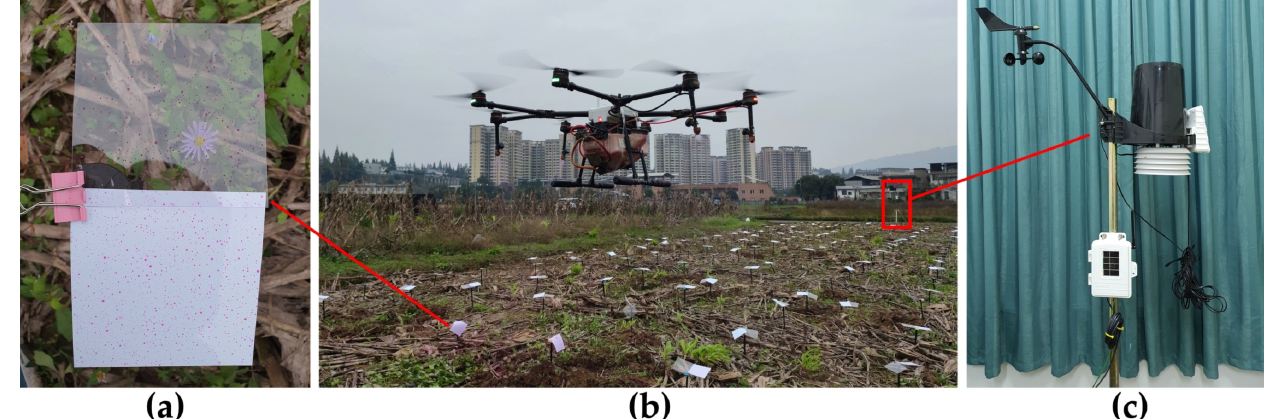
Figure 15. UAV plant protection operation controlled by variable spray system.